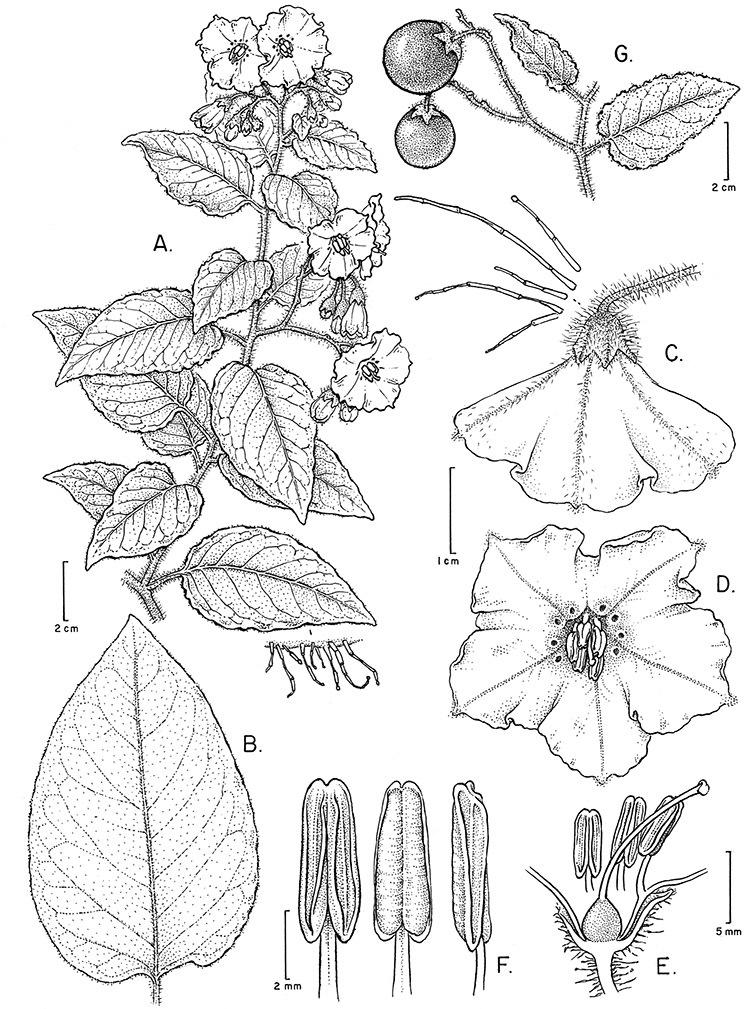
Solanum wallacei (A. Gray) Parish. (A, C–F drawn from Moran 687
B drawn from Trask s.n., coll. May 1896 G drawn from Walker 1433). Illustration by Bobbi Angell.